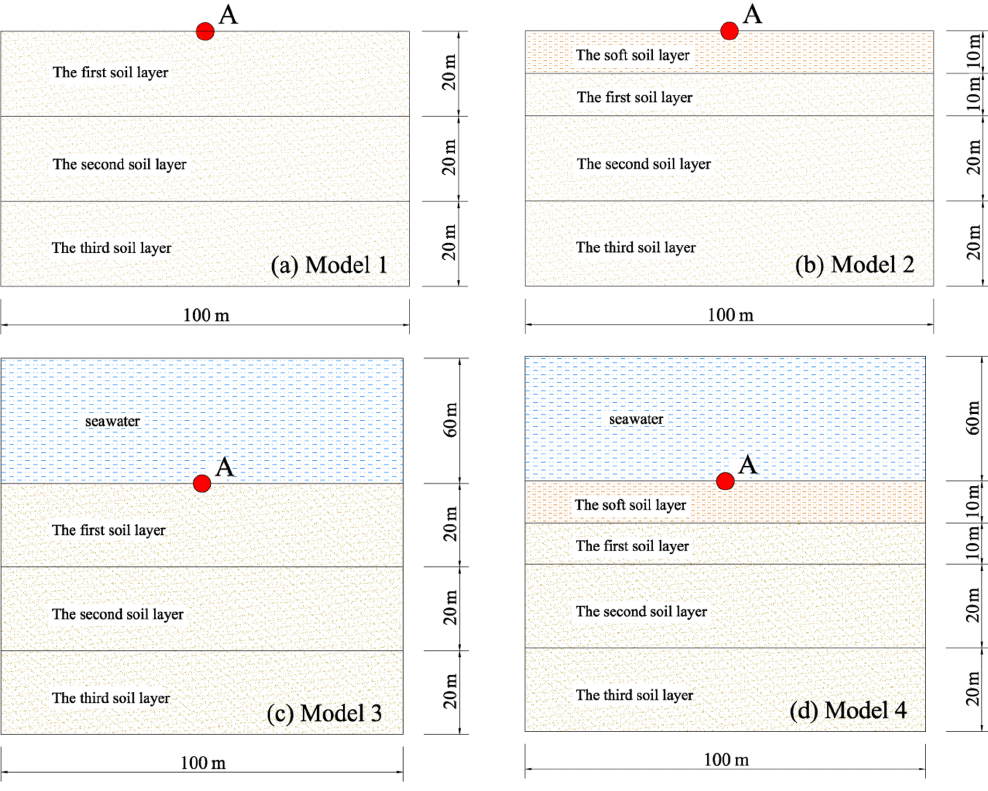
Figure 1. Four typical free-field models. Table 1. Parameter of the stratified layer model. Basic properties Soft soil